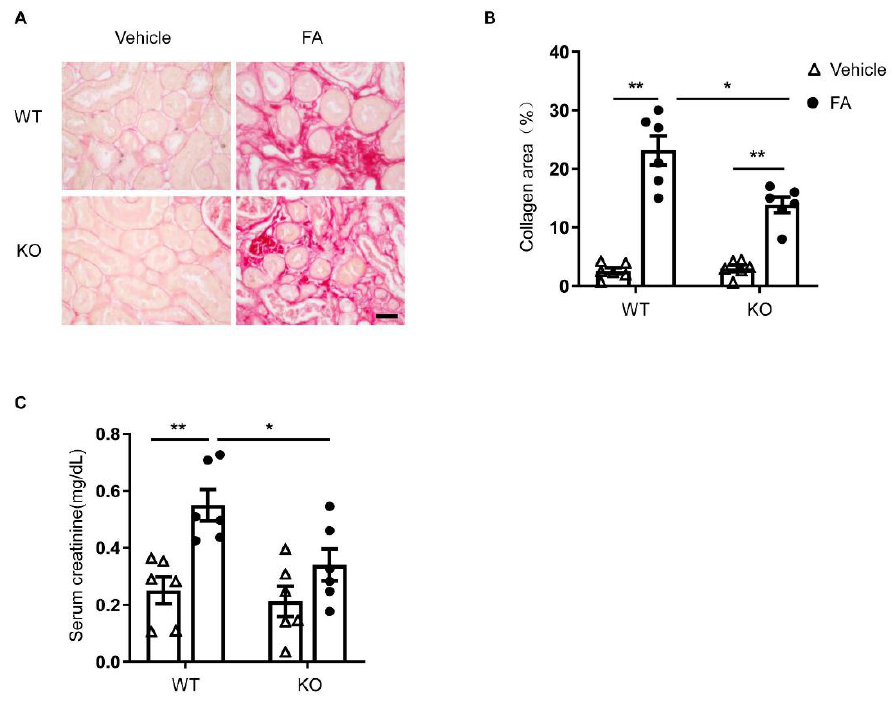
Figure 6. STAT6 deficiency ameliorates renal fibrosis and preserves kidney function in folic acid nephropathy. ( A ) Representative photomicrographs of kidney sections stained with Sirius red for assessment of total collagen deposition in the kidneys. Scale bar, 50 μm. ( B ) Quantitative analysis of interstitial collagen deposition in the kidneys. ** p < 0.01; * p < 0.05. n = 6 per group. ( C ) Effect of STAT6 deficiency on serum creatinine. ** p < 0.01; * p < 0.05. n = 6 per group.